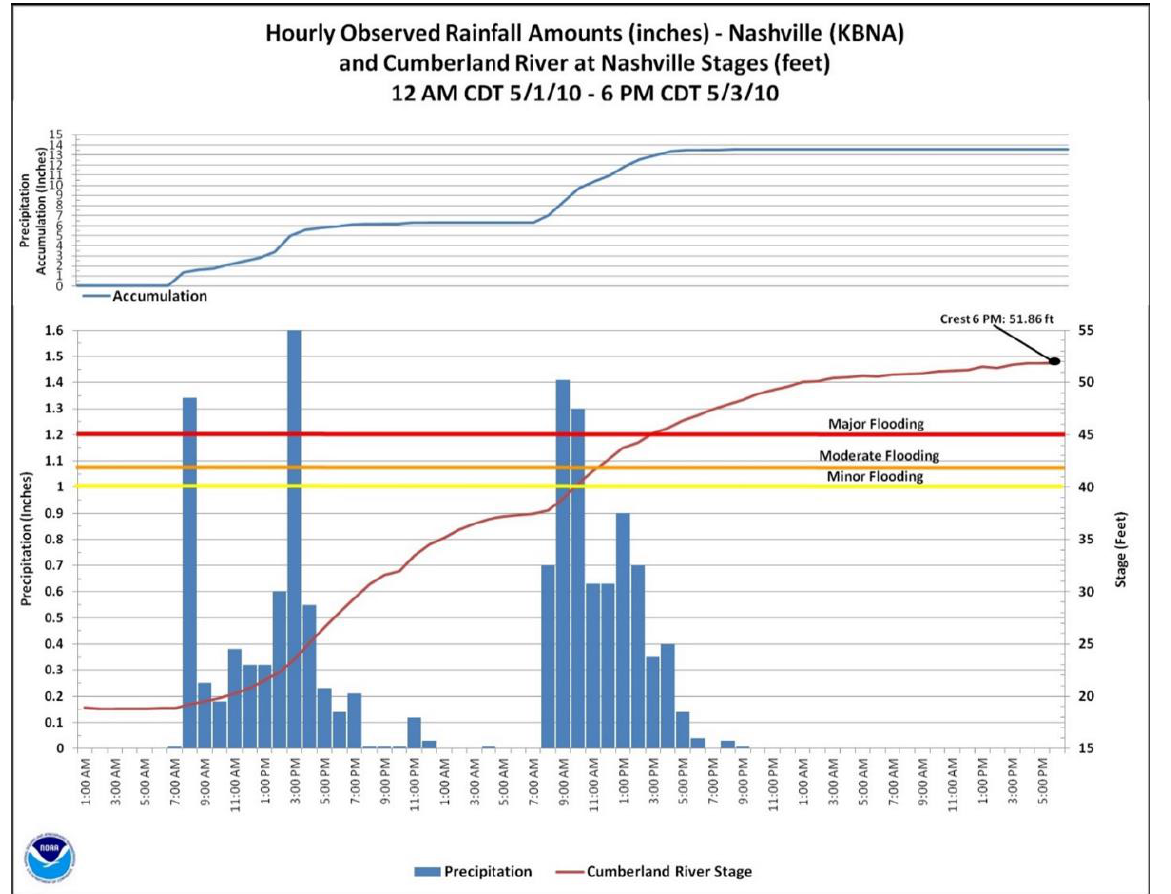
Figure 3. Hourly and accumulative rainfall at Nashville International Airport from 12:00 a.m. 1 May 2010 to 12:00 a.m., 3 May 2010. [24].